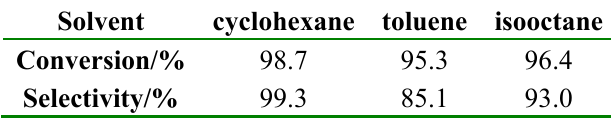
Table 3. The effect of the solvents on the